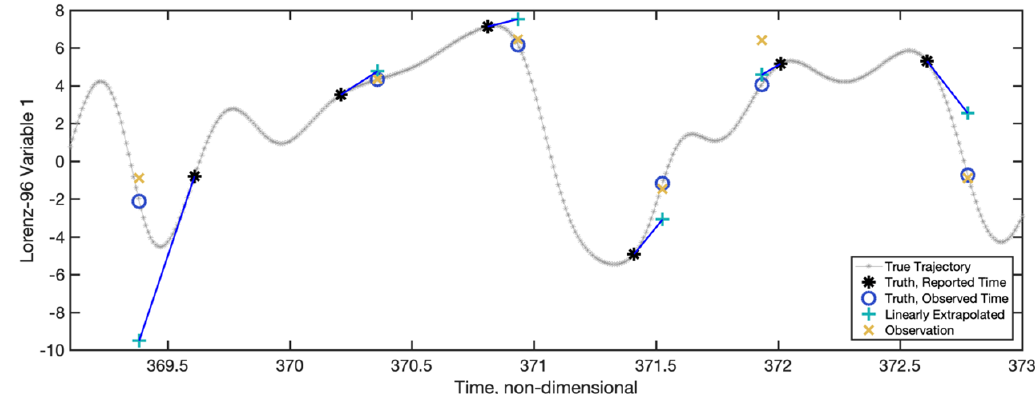
Figure 1. A short segment of the truth for a state variable and the observation generation process from the case with an analysis period of 0.6 and time error standard deviation of 0.2. The true trajectory is indicated by the small grey asterisks every 0.01 time units. The black asterisks indicate the true value at each analysis time. The blue circles are the truth at the actual observed time (the analysis time plus the observation time offset for that analysis time). The yellow crosses are the actual observations that are assimilated and are generated by adding a random draw from N (0 , 1) to the truth at the actual observed time. The teal “ + ” symbols indicate the result of linearly extrapolating the truth at the analysis time to the actual observed time using the time derivative of the model at the analysis time ( v in Eq. 1); a blue line segment connects the truth to the extrapolated